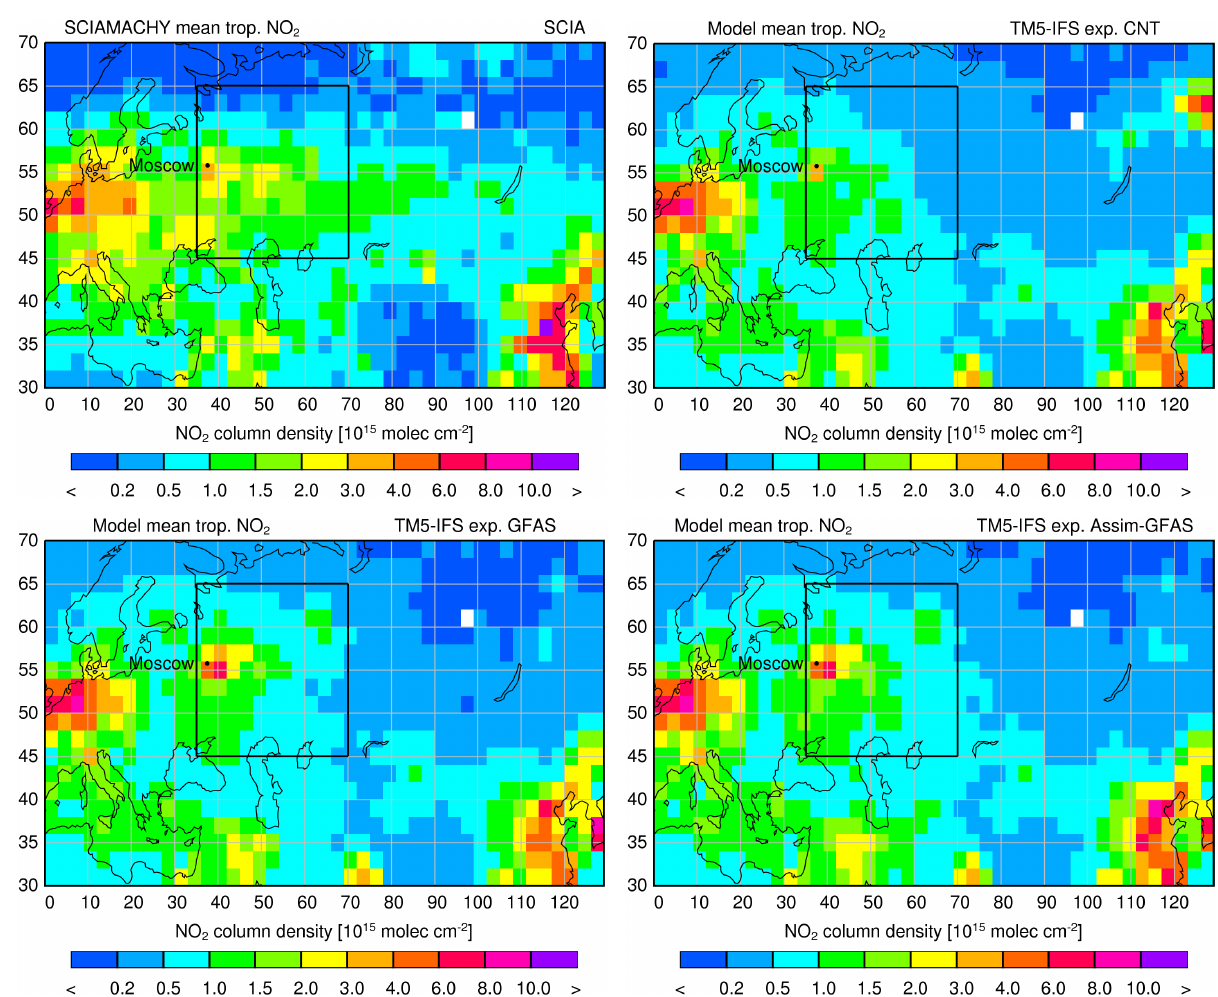
Fig. 12. Maps of mean tropospheric NO 2 columns as observed from SCIAMACHY between 20 July and 15 August compared to the D+0 columns from the runs CNT, GFAS and Assim-GFAS.